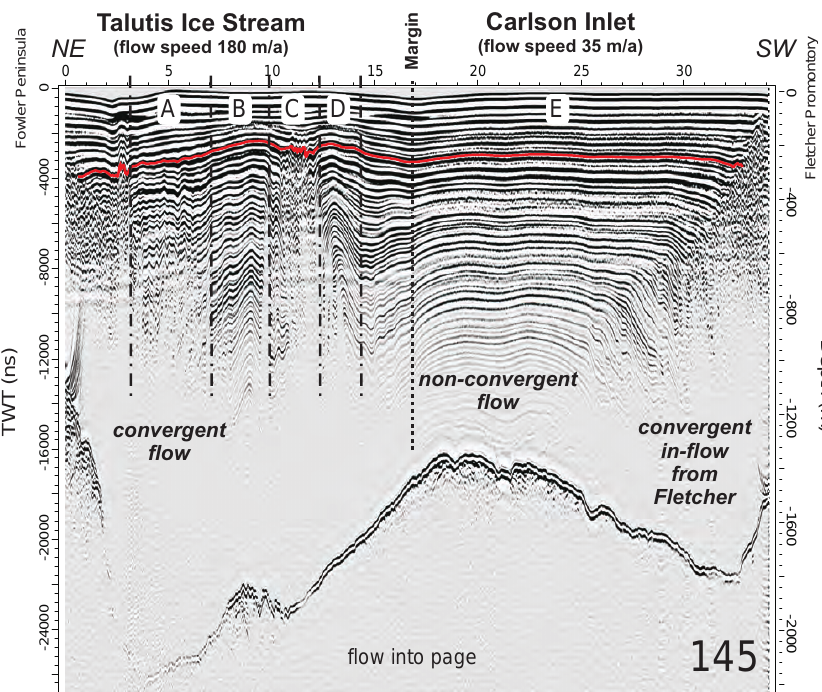
Fig. 3. Radargram across the downstream end of Carlson Inlet showing the contrast in isochrone structure between open, bed-conformable folds in the centre of Carlson Inlet and short-wavelength folds in Talutis Ice Stream. The shear margin between Talutis Ice Stream and Carlson Inlet (marked at the location of the surface flow speed change) is not crevassed despite a flow-speed differential of 145ma − 1 . Red line marks isochrone mapped in 3-D in Fig. 4a and the letters A to E mark zones of different styles of